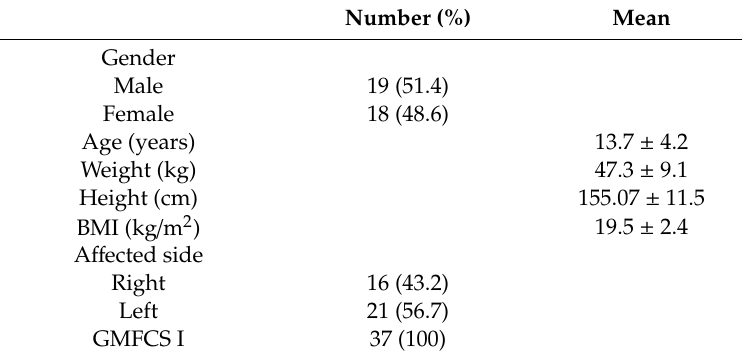
Table 1. Characteristics of the study